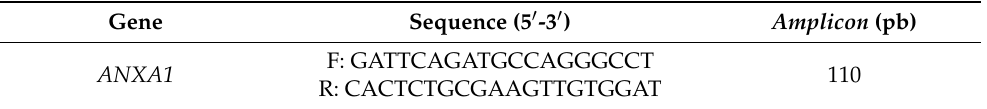
Table 3. Sequences of primers used in qPCR reactions for the different targets. Annexin A1 ( ANXA1